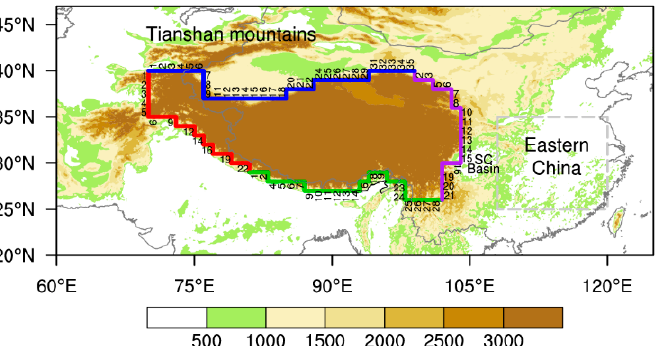
Figure 1. The boundaries (elevation greater than 2000 m) of the Tibetan Plateau (TP), where the southern, western, northern, and eastern boundaries are denoted in green, red, blue, and purple, respectively. The numbers are the series of sub-boundaries (1° latitude or longitude) on each boundary. The dashed gray rectangle (108°–120° E, 25°–35° N) denotes eastern China region.